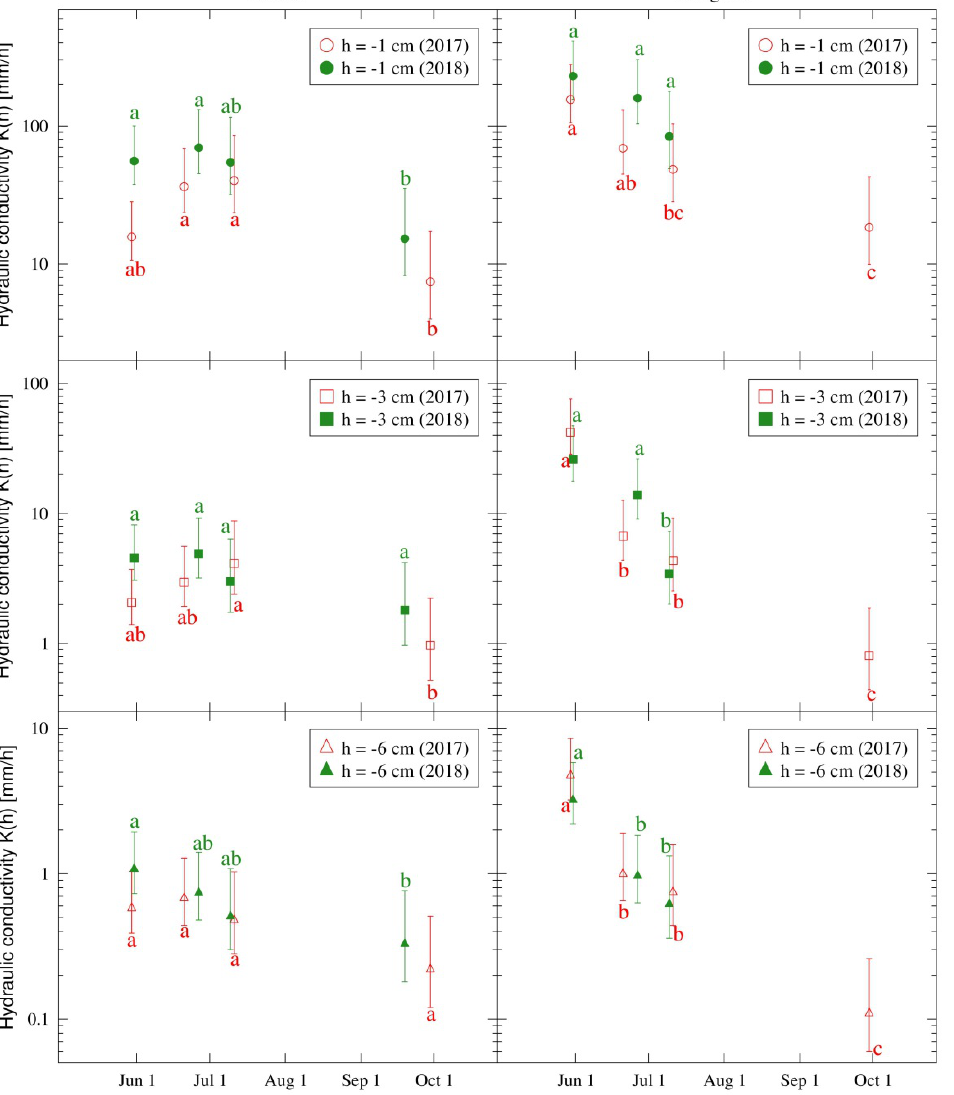
Fig. 4. Median estimates of near-saturated hydraulic conductivity (K(h)) measured using different supply pressure head (h; −1, −3, −6 cm) in (left) no-till and (right) autumn-ploughed plots in Kotkanoja leaching field, 2017−2018. Error bars denote 95% confidence interval. Different letters (a, b, c) indicate statistically significant differences between sampling sites (within pressure head and